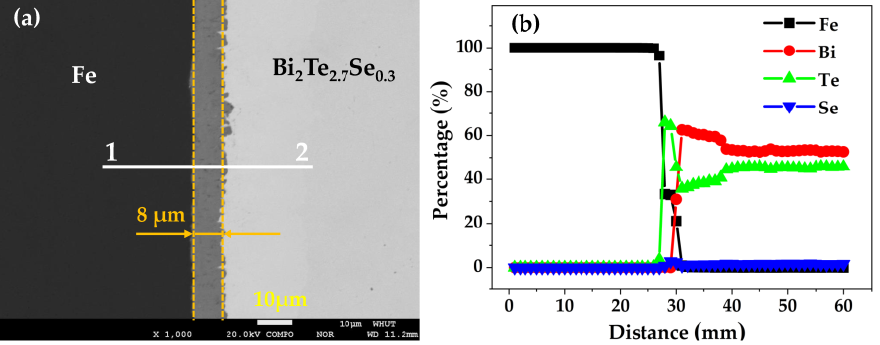
Figure 6. ( a ) BEI; ( b ) elemental line profiles of Fe, Bi, Te and Se elements at the Fe/BTS interface.